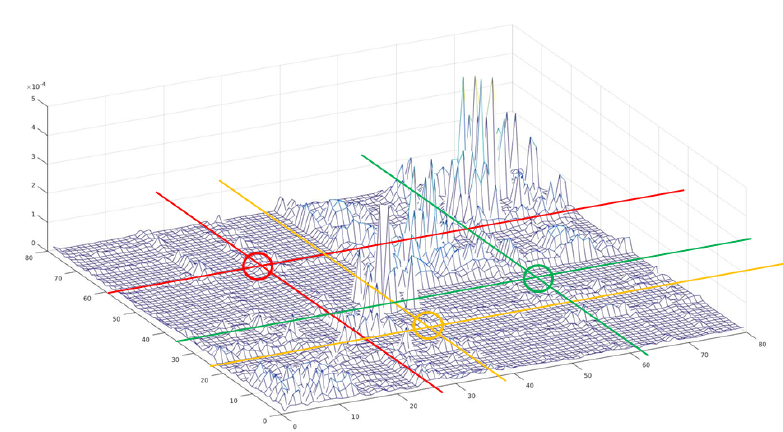
Figure 6. Histogram of the co-occurrences between object categories. The negative set was generated by selecting the combinations of the less correlated categories (e.g., combinations shown in circled